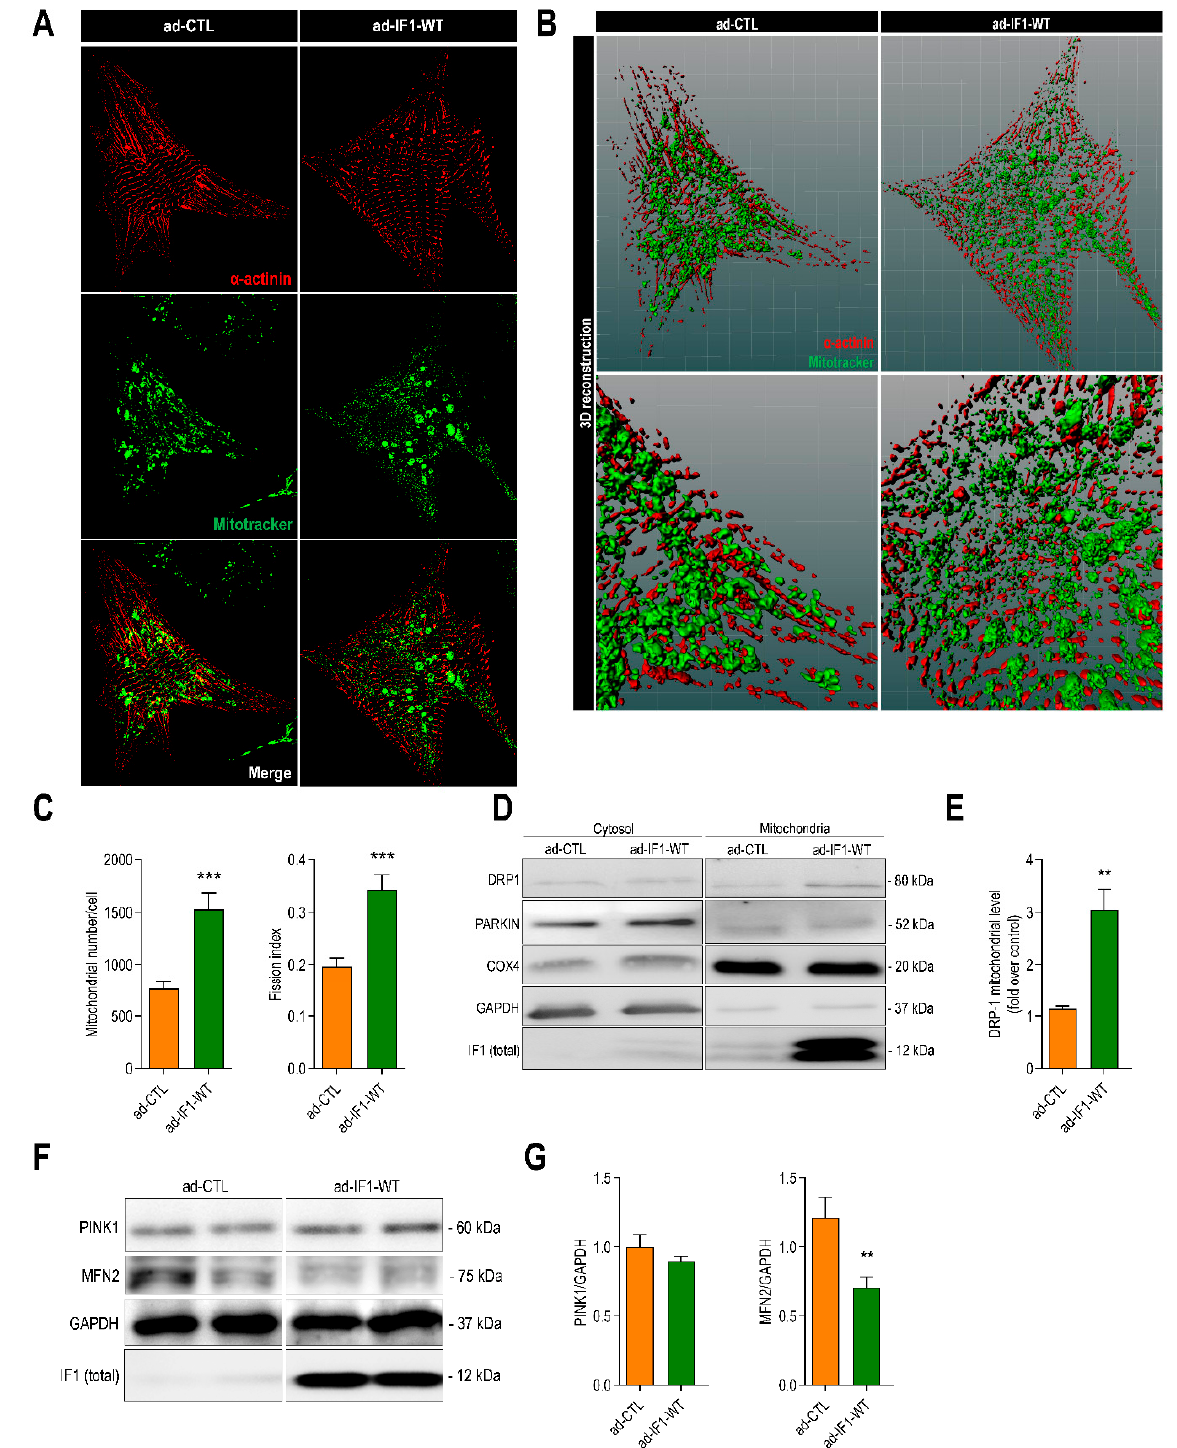
Figure 4. IF1 induces mitochondrial fission by promoting dynamin-related protein 1 (DRP1) translocation. NRVMs were infected with adenovirus ad-IF1-WT or empty vector (ad-CTL) for 48 h. ( A ) Representative Z-stack image of neonatal rat ventricular myocyte stained with MitoTracker ® Deep Red (green) and anti- α -actinin (red) using confocal microscopy. ( B ) 3D imaging reconstruction was employed for mitochondrial network analysis (30–36 Z-stacks slices were recorded per cell). Representative example of confocal stack acquisition followed by 3D reconstruction after image deconvolution of cells stained as in A. ( C ) Bar graphs depicting differences in mitochondrial number per cell (left bar graph) and fission index (right bar graph). Both ratios were calculated from 3D multislice reconstruction values. Fission index estimation was measured using the number of mitochondrial normalized for mitochondrial volume per cell (ad-CTL, n = 17 cells and ad-IF1-WT, n = 18 cells). ( D ) Dynamin-related protein 1 (DRP1), cytochrome c oxidase subunit 4 (COXIV), and glycer-